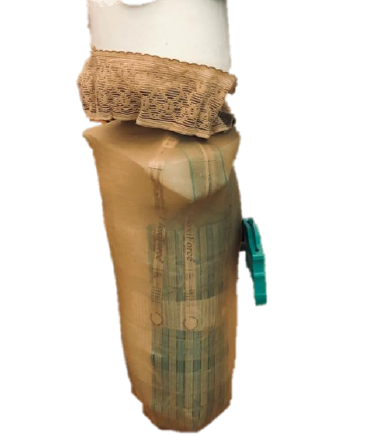
Figure 12. Artificial residuum with the socket interface pressure (SIFP) sensor and F-Socket sensors before the socket is